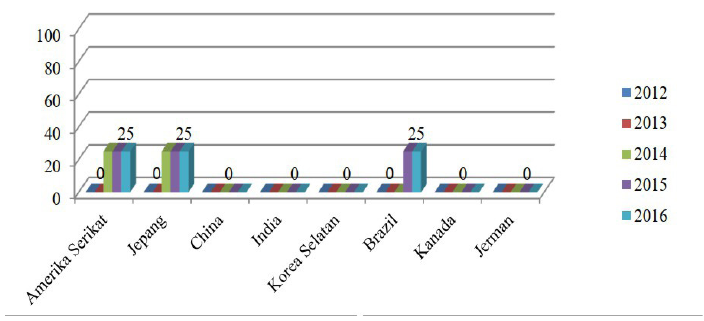
Figure 1: Frequency Index SPS (%) of Natural Rubber Export to Major Destination Coun - tries, 2012-2016